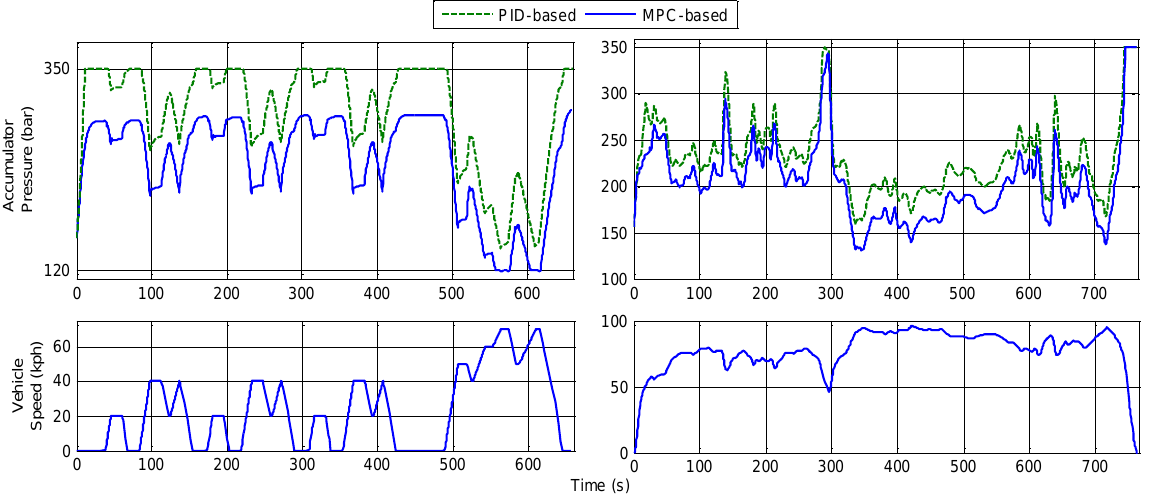
Figure 15. System behaviors under Japan 1015 driving cycle with MPC-based and PID-based control scheme.